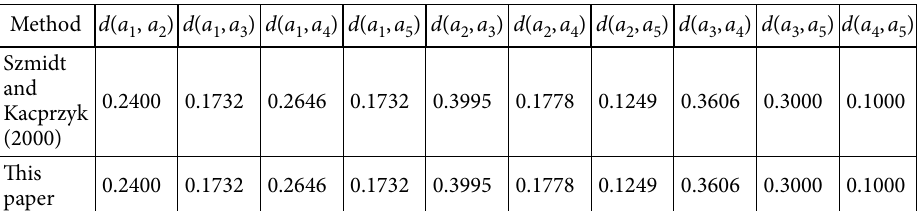
Table 3. Calculation results of the Euclidean distances between